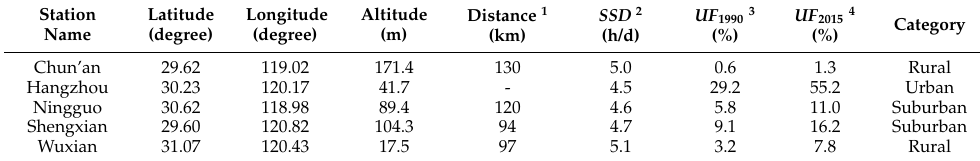
Table 1. Basic information for the selected five meteorological stations near Hangzhou City,